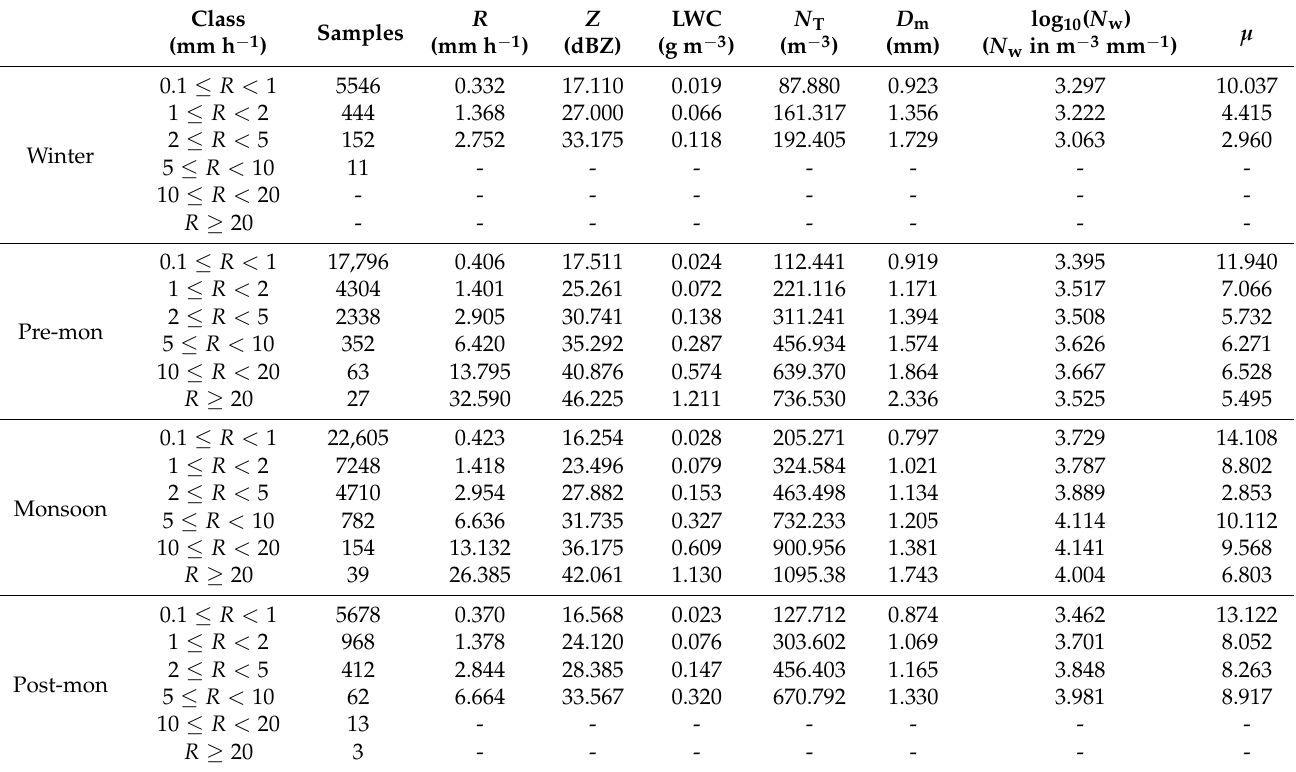
Table 4. Average rainfall microphysical parameters for each of the six rainfall rate classes in the winter, premonsoon, monsoon and postmonsoon